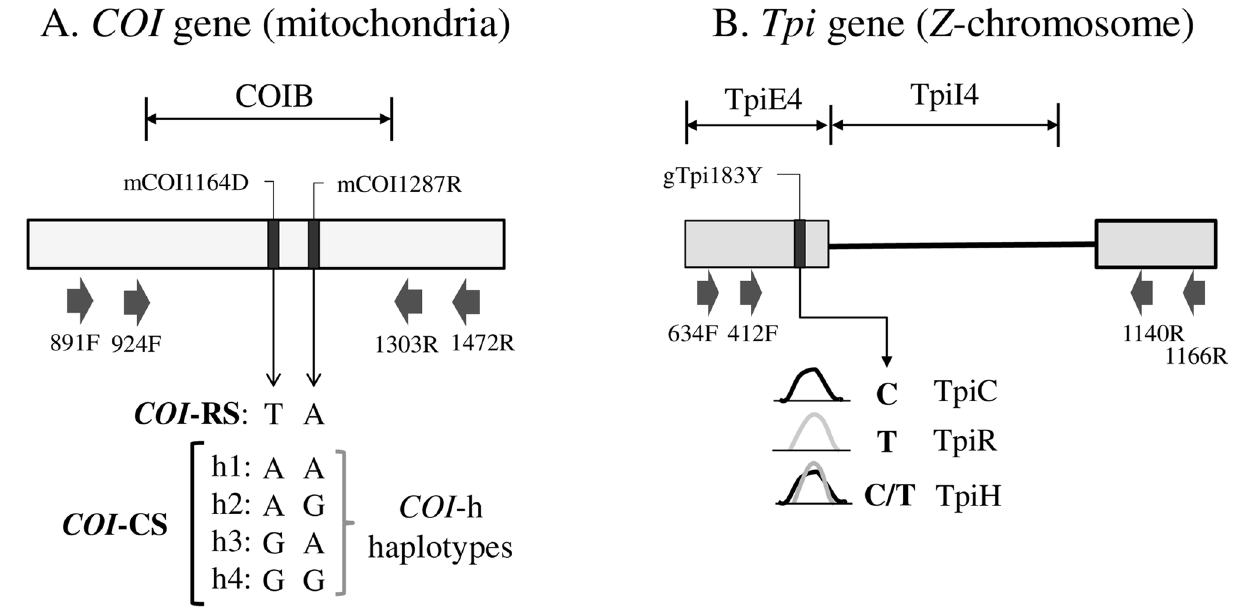
Figure 2. Diagrams of the segments from the COI and Tpi genes used for the genetic analysis (derived from 42 ). ( A ) COIB gene segment identifying PCR primers used to amplify the fragment (block arrows) and the strain and COI -h haplotype defining the mCOI1164D and mCOI1287R polymorphic sites. CO1 -RS is defined as a T and A at mCOI1164D and mCOI1287R, respectively. There are four corn-strain ( CO1 -CS) haplotypes (h1–h4) with an A or G observed at both mCOI1164D and mCOI1287R. ( B ) Portion of the fall armyworm Tpi gene with block arrows indicating PCR primers. The TpiE4 exon segment contains the gTpi183 site that is polymorphic for a C or T. Representative DNA chromatograph patterns are shown to illustrate how TpiC, TpiR, and TpiH are defined. The TpiI4 intron segment lies adjacent.